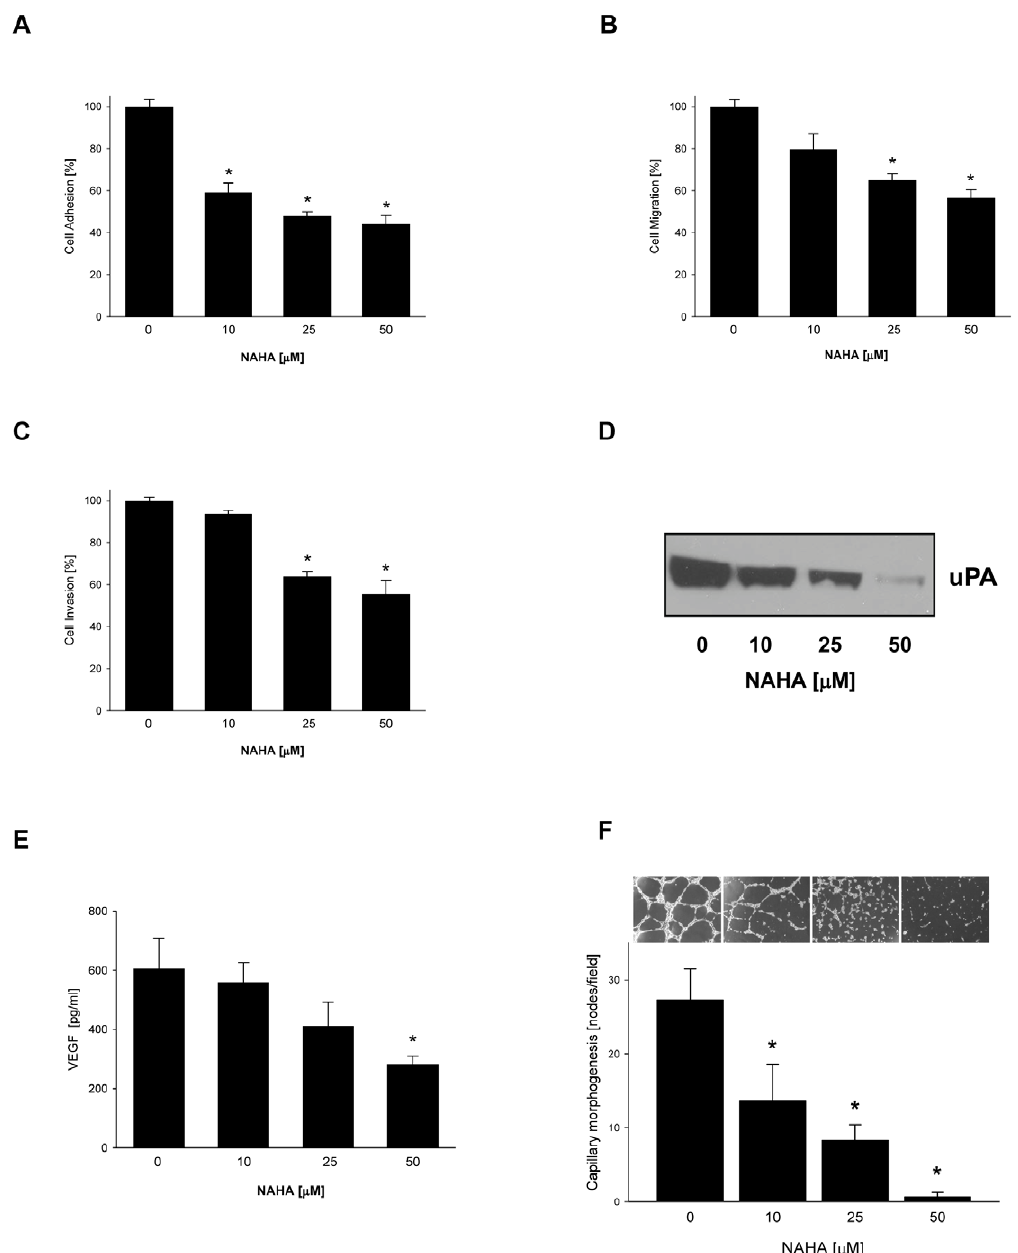
Figure 2. NAHA inhibits invasive behavior of breast cancer cells and capillary morphogenesis of endothelial cells. (A) Cell adhesion. MDA-MB-231 cells were treated with NAHA (0–50 m M) for 24 hours and cell adhesion to vitronectin determined as described in Materials and Methods . Each bar represents the mean 6 SD of three experiments. * p , 0.05. (B) Cell migration. Cell migration of MDA-MB-231 cells was determined after 5 hours of incubation in the presence of NAHA (0–50 m M), as described in Materials and Methods . Each bar represents the mean 6 SD of